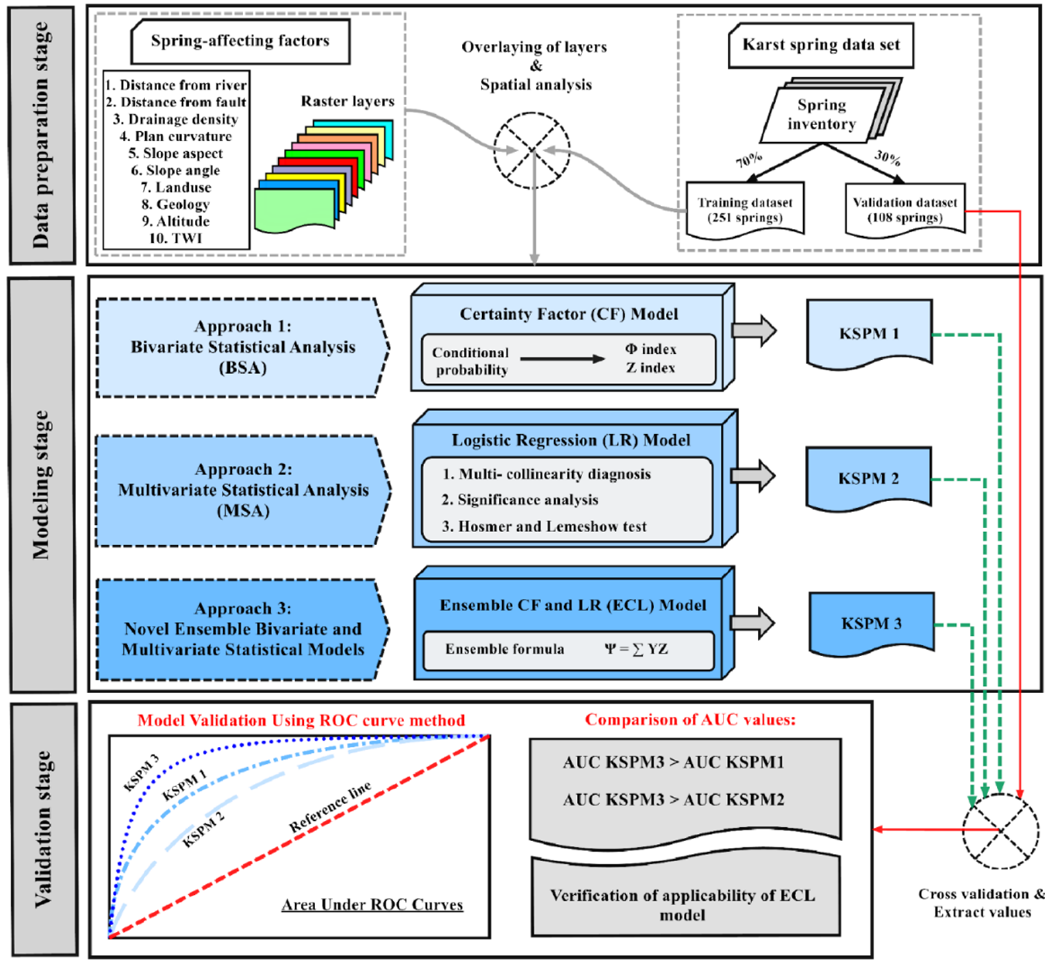
Figure 2. Methodology fl owchart used in the study.